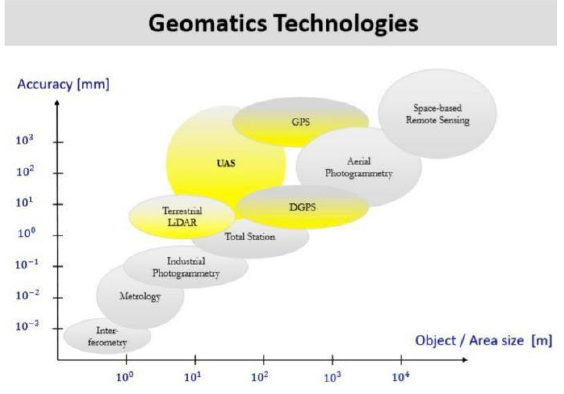
Figure 1. Accuracy of Most Common Surveying